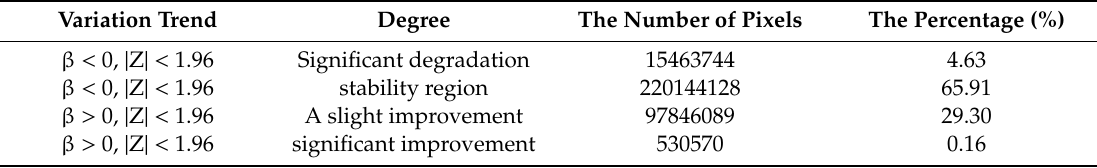
Table 1. The NDVI (Normalized Difference Vegetation Index) of trend statistics. Variation Trend Degree The Number of Pixels The Percentage (%) Variation trend Degree β < 0, | Z | < 1.96 Significant